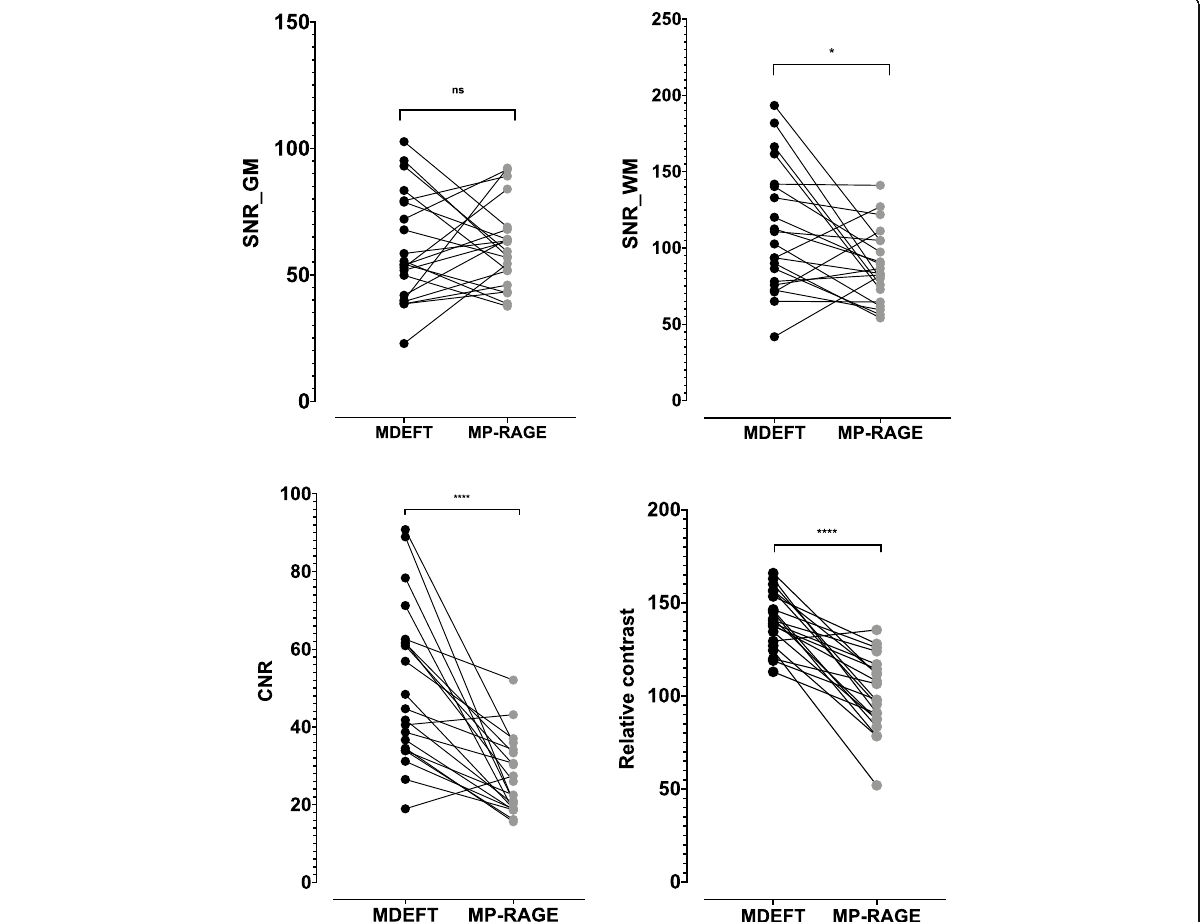
Fig. 3 Mean differences graph of SNR in gray matter (GM) and white matter, CNR, and relative contrast between MDEFT and MP-RAGE pulse